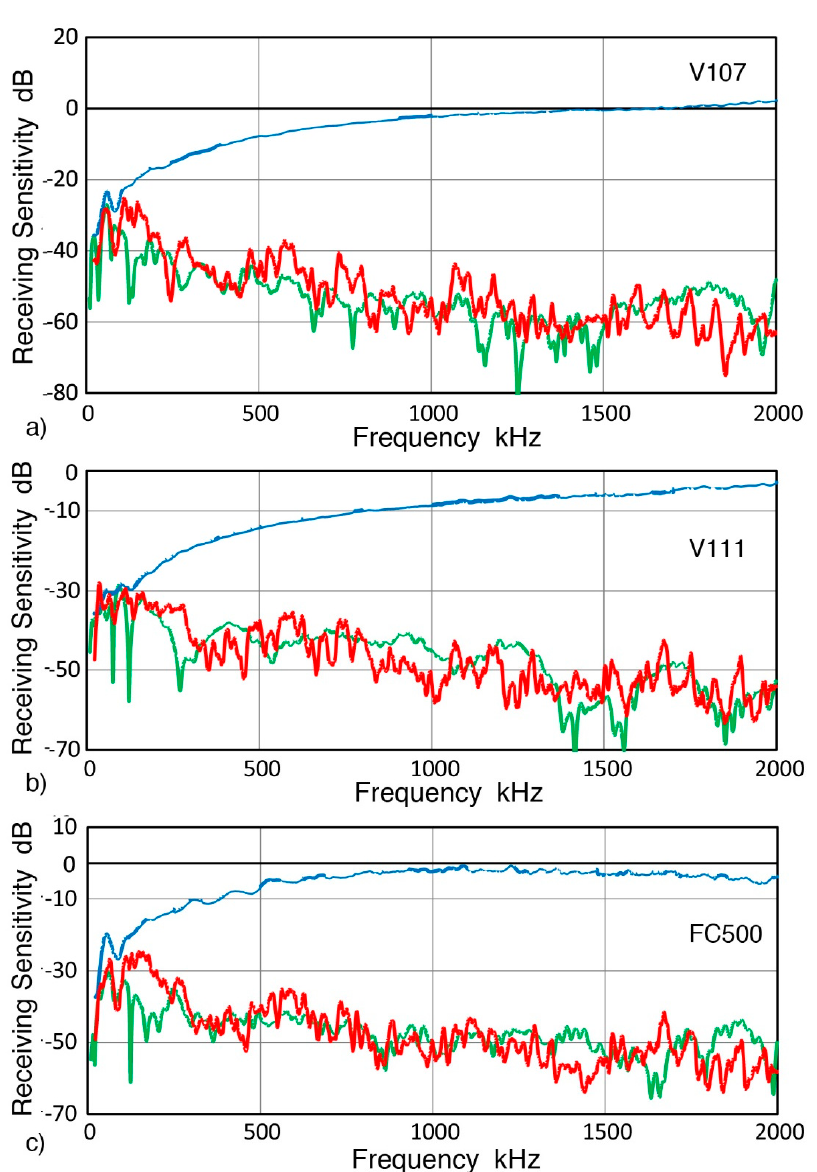
Figure A4. Receiving sensitivities of three ultrasonic transducers to three wave modes, NW (blue curves), RW (green curves), and GW (red curves). ( a ) Olympus V107 transducer, ( b ) V111 transducer, and ( c ) AET FC500 transducer.